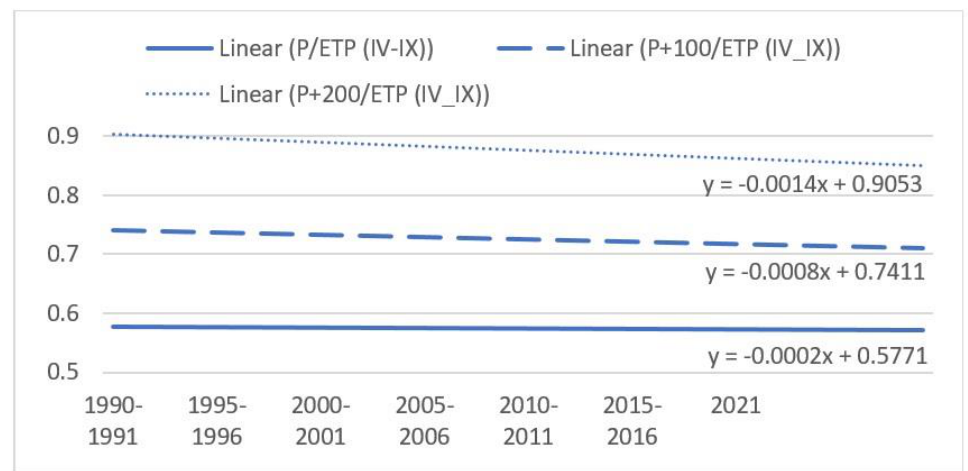
Figure 20. Scenarios of evolution of the ratio of the values of the accumulated precipitations in the warm period of the year, with the evapotranspiration, registered annually in Timișoara, Romania, P/ETP (IV – IX), 1990 –